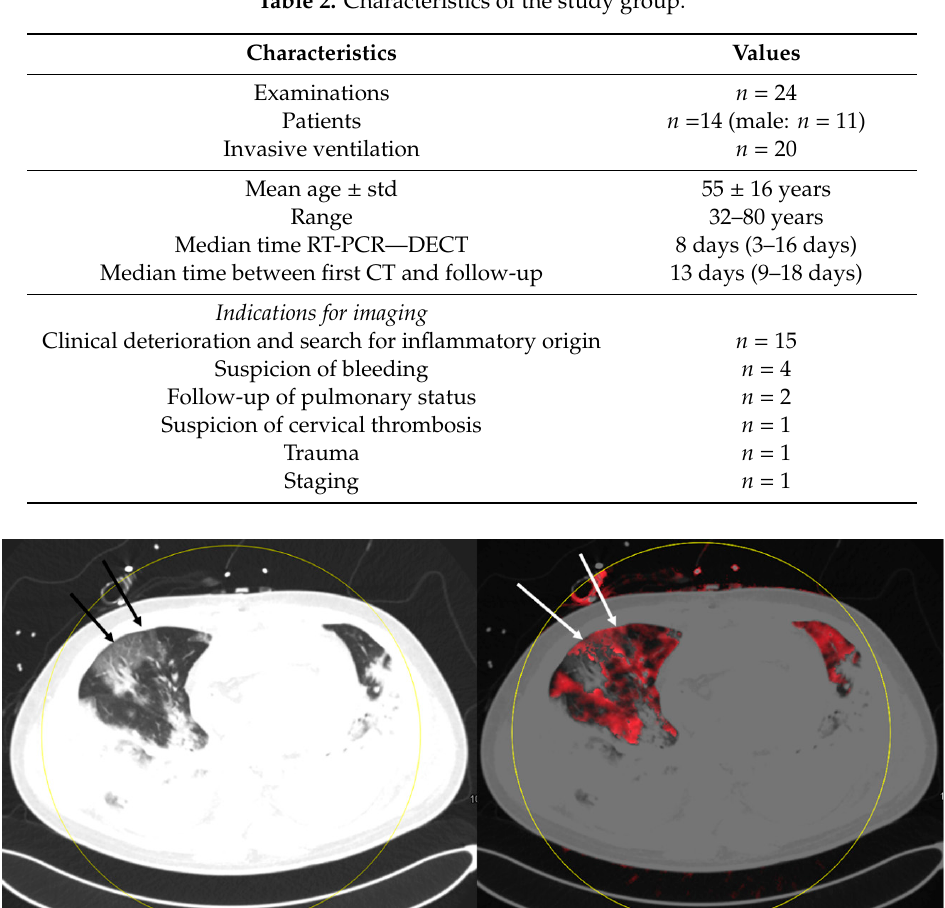
Table 2. Characteristics of the study